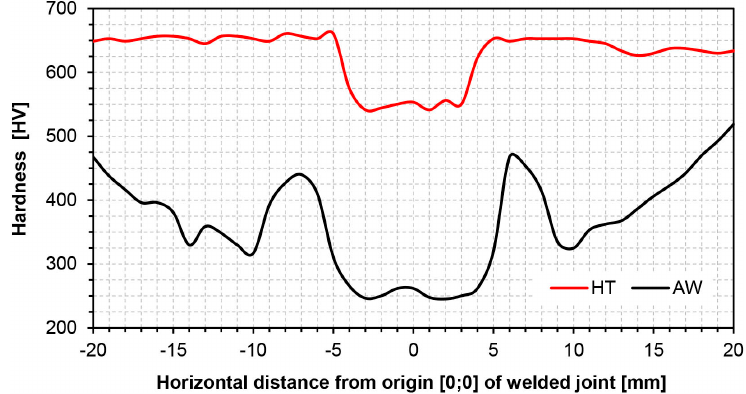
Figure 6. Macroscopic image of cross-section of a Hardox Extreme welded joint after heat treatment. WM—weld metal zone, FZ—fusion zone, BM—base material zone, HAZ—heat-affected zone. Stereoscopic microscopy, etched with 3% HNO 3 .